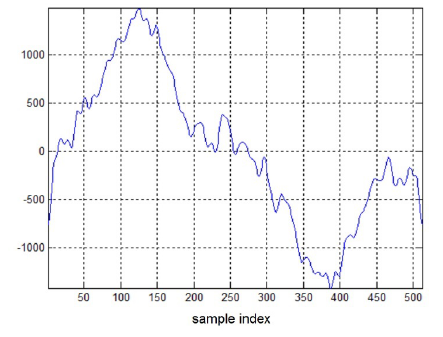
Figure 2. A period from an artificial white noise corresponding to the lowest power of